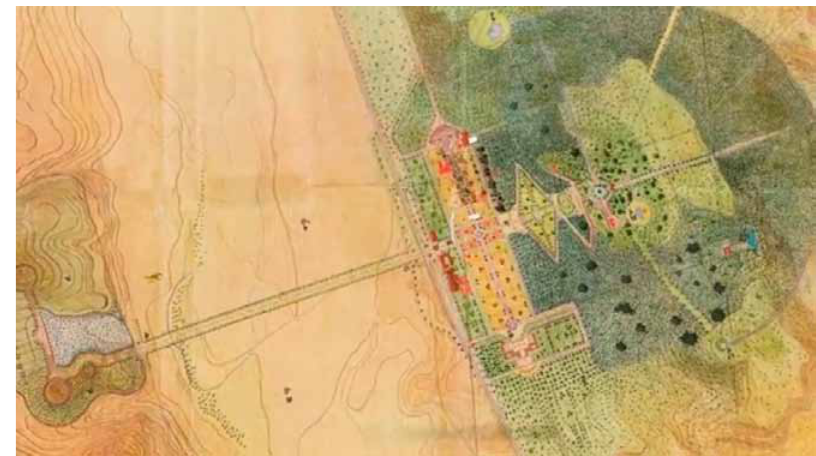
fig. 2. The plan of Egli for forest farm (aoÇ araştırmaları